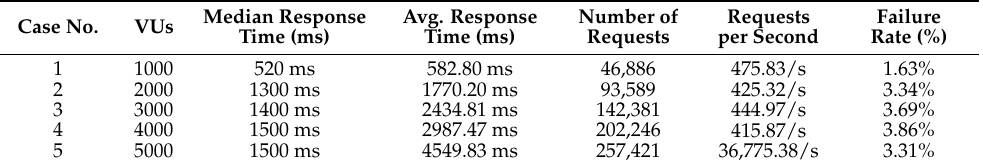
Table 3. Performance for 2-policy routing: Policy 2. Avoid crowded areas, plus Policy 3. Avoid polluted areas.